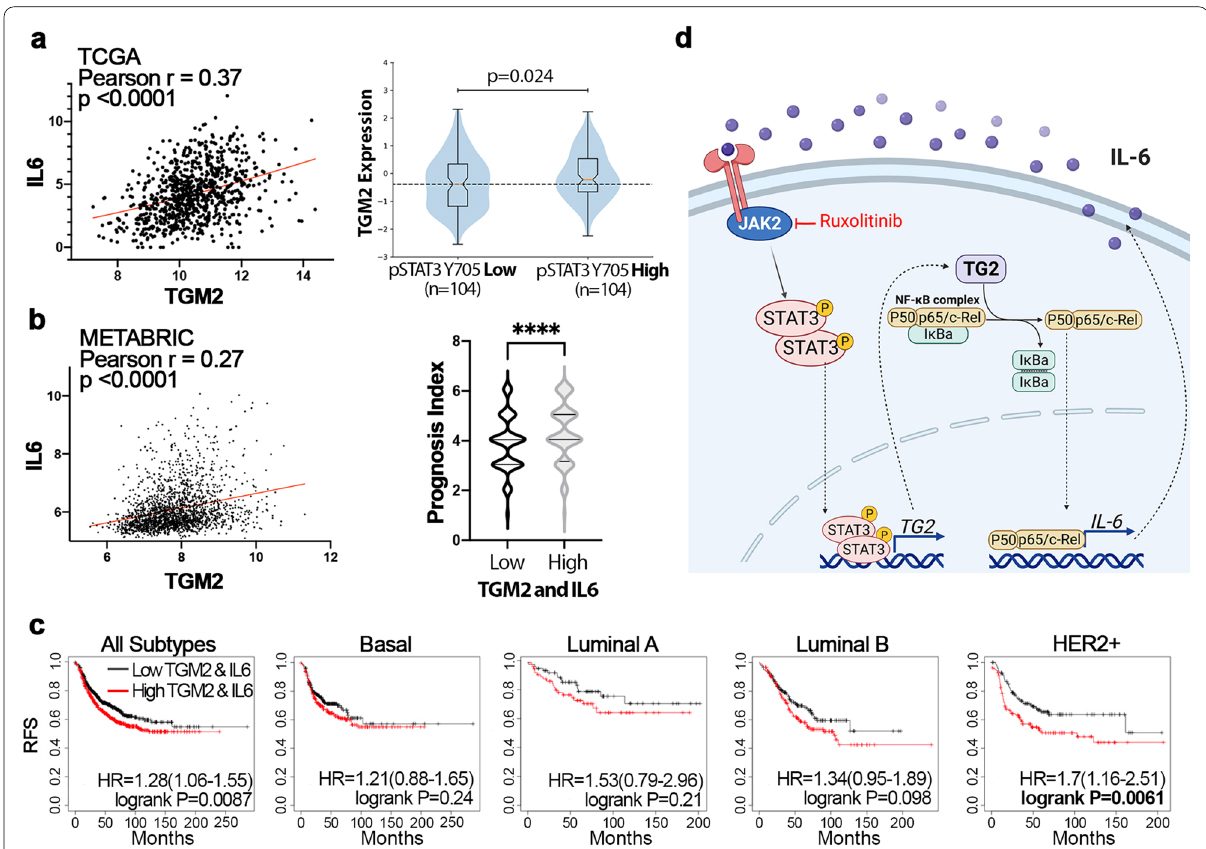
Fig. 6 Expression of TG2 and IL6 predict disease recurrence in HER2 breast cancer. a Left, Correlation analysis of the TCGA dataset comparing + IL6 and TGM2. Data were analyzed using a Pearson correlation test, yielding the indicated r and p values. Right, comparison of TGM2 expression in patient samples bearing high (above the mean) or low (below the mean) phosphorylation of STAT3. b Left, Correlation analysis of the METABRIC dataset comparing IL6 and TGM2. Data were analyzed as in panel (a). Right, comparison of Nottingham Prognosis Indexes for patients with high (above the mean) or low (below the mean) expression of TGM2 and IL6. Data were analyzed by a student’s T-test where **** is p < 0.0001. c Kaplan Meier analyses for relapse free survival (RFS) of patients with high (above the mean) or low (below the mean) expression of fibronectin, TGM2, and IL6. Data were analyzed by a logrank test. d A schematic representation of a TG2-mediated drug persistence loop where breast cancer cells upregulate TG2 driving NF-κB-mediated expression of IL-6. Autocrine and paracrine IL-6-mediated activation of JAK:STAT3 signaling contributes to maintained expression of TG2 completing the drug persistence signaling loop. Application of the JAK2 inhibitor ruxolitinib can disrupt this